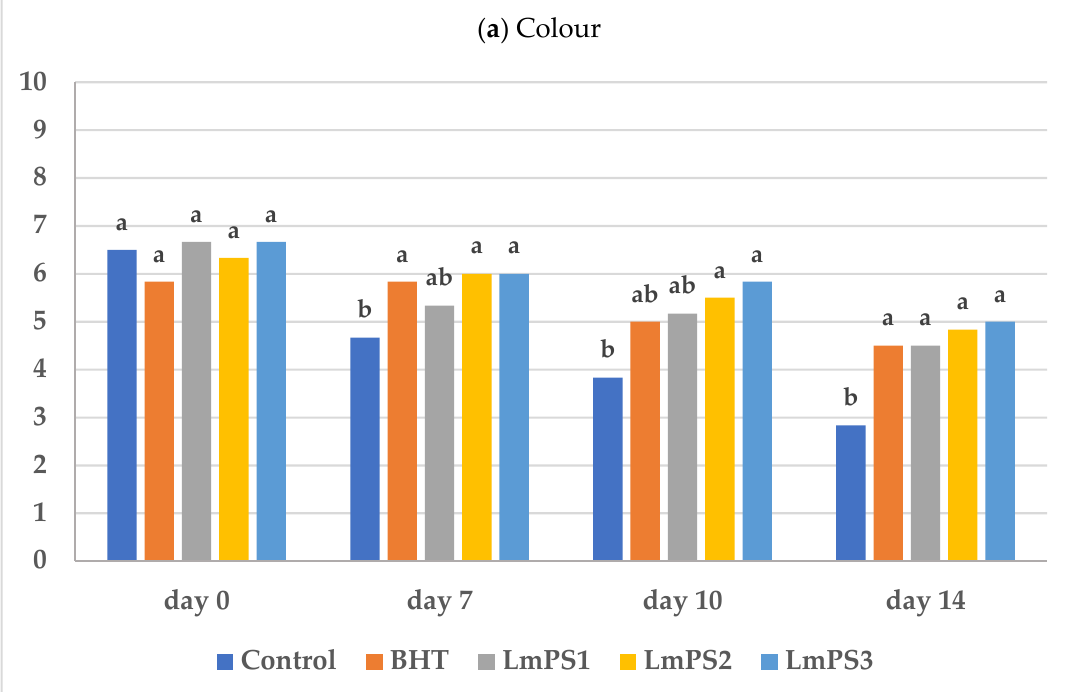
Figure 1. Lm PS incorporation effect on ( a ) pH, ( b ) metmyoglobin (%), and ( c ) thiobarbituric-acid reactive substances (TBARS) (mg malondialdehyde/kg) in crude minced meet within a shelf life of 14 days of storage at 4 °C. Mean ± standard deviation ( n = 3). Letters a–d: values of the same storage day are significantly different ( p < 0.05); letters A–D: values of the same concentration are signifi- cantly different.